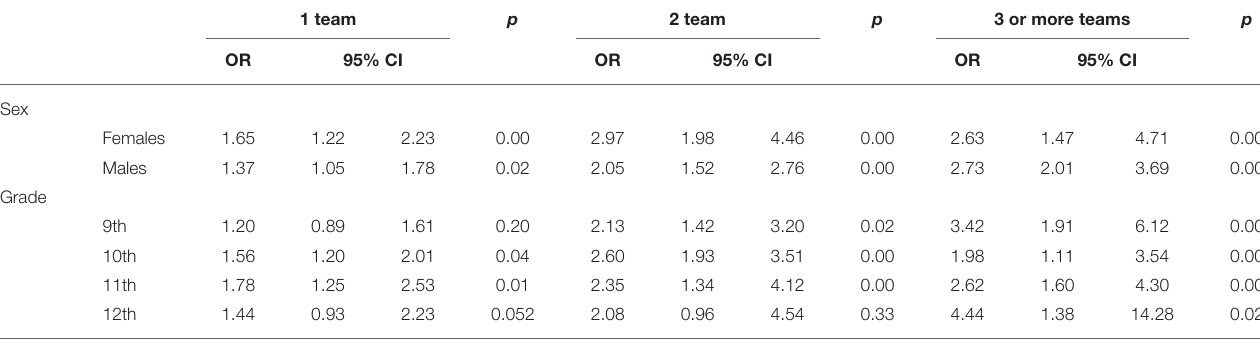
TABLE 3 | Relationship between academic performance and participation in sports team by sex and